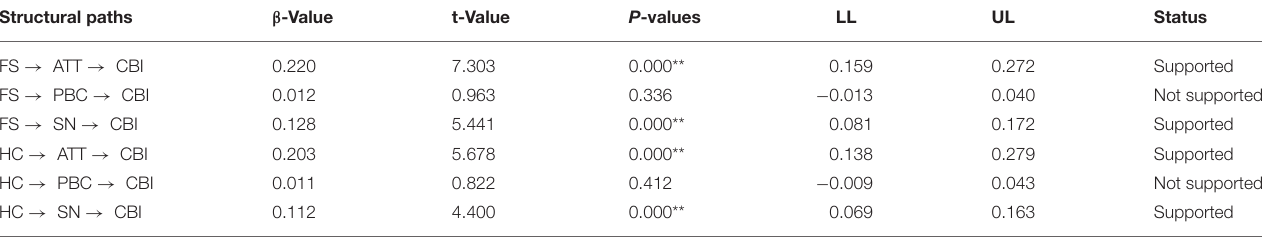
TABLE 7 | Mediation effect. Structural paths β -Value t-Value P